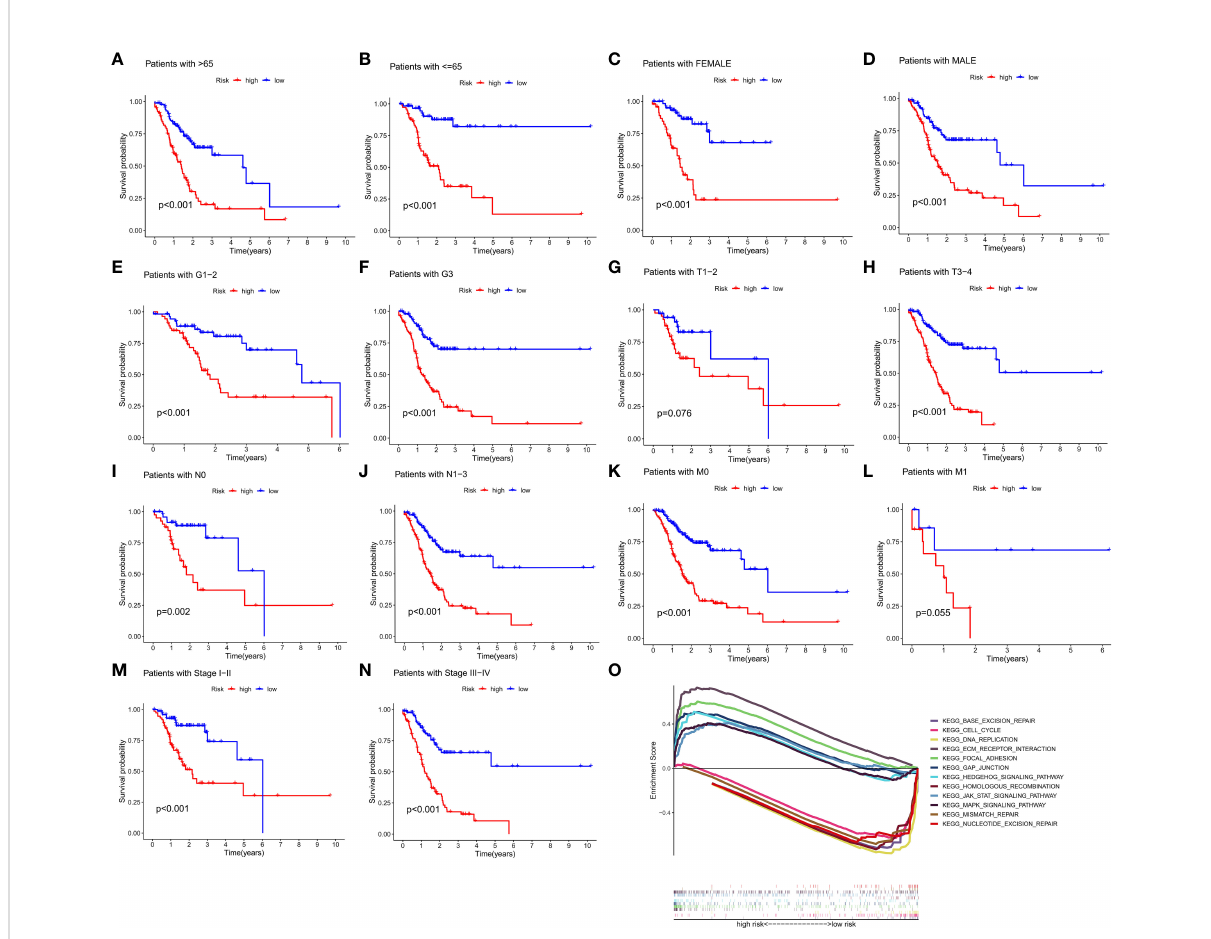
FIGURE 5 The prognostic function of the risk model and GSEA of 10 lncRNAs in the risk model. (A – N) The survival outcome of patients with different risk patterns was assessed in different subgroups. (O) GSEA results of 10 lncRNAs were visualized. (p <